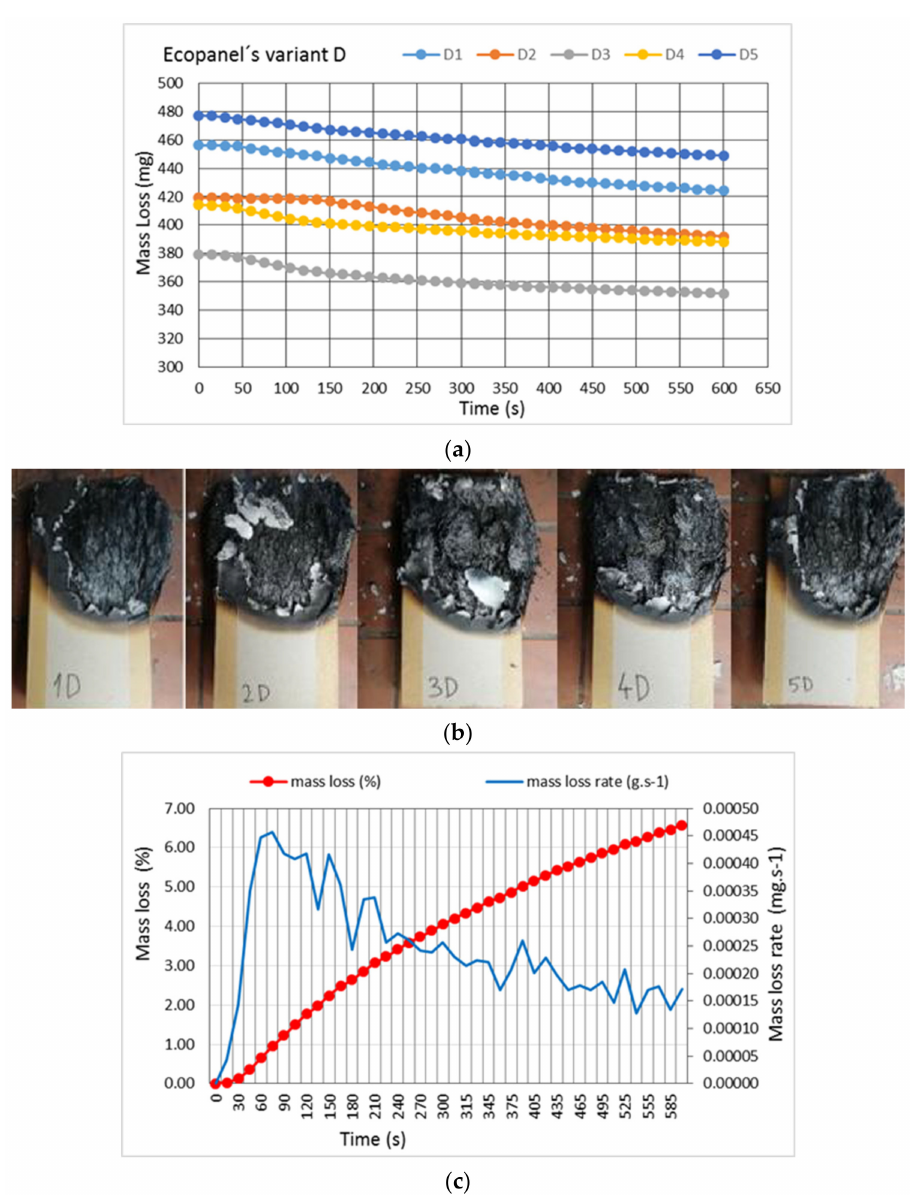
Figure 9. ( a ) Weight loss of D samples over time; ( b ) Group D samples after the experiment, exposure time 10 min; ( c ) The increase in mass loss and the burning rate of D samples. All charts display average values of all the